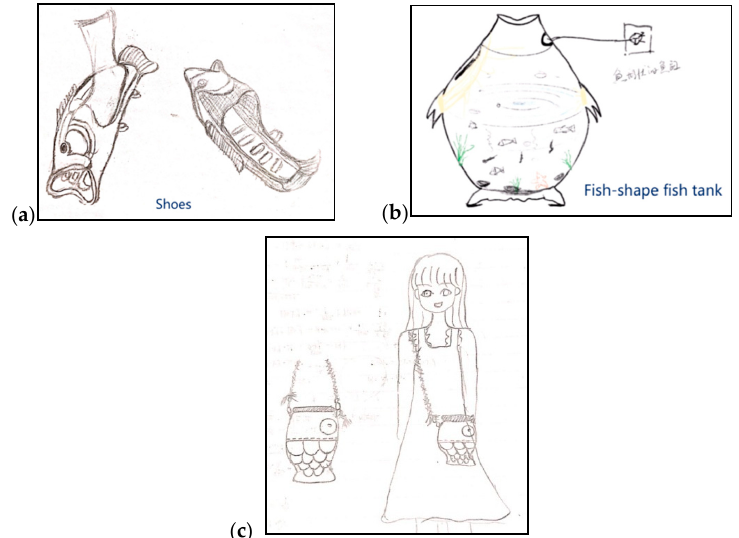
Figure 3. Examples of High, Middle, and Low creativity quality level results. ( a ) An example of a High level of creativity quality. ( b ) An example of a Middle level of creativity quality. ( c ) An example of a Low level of creativity quality.